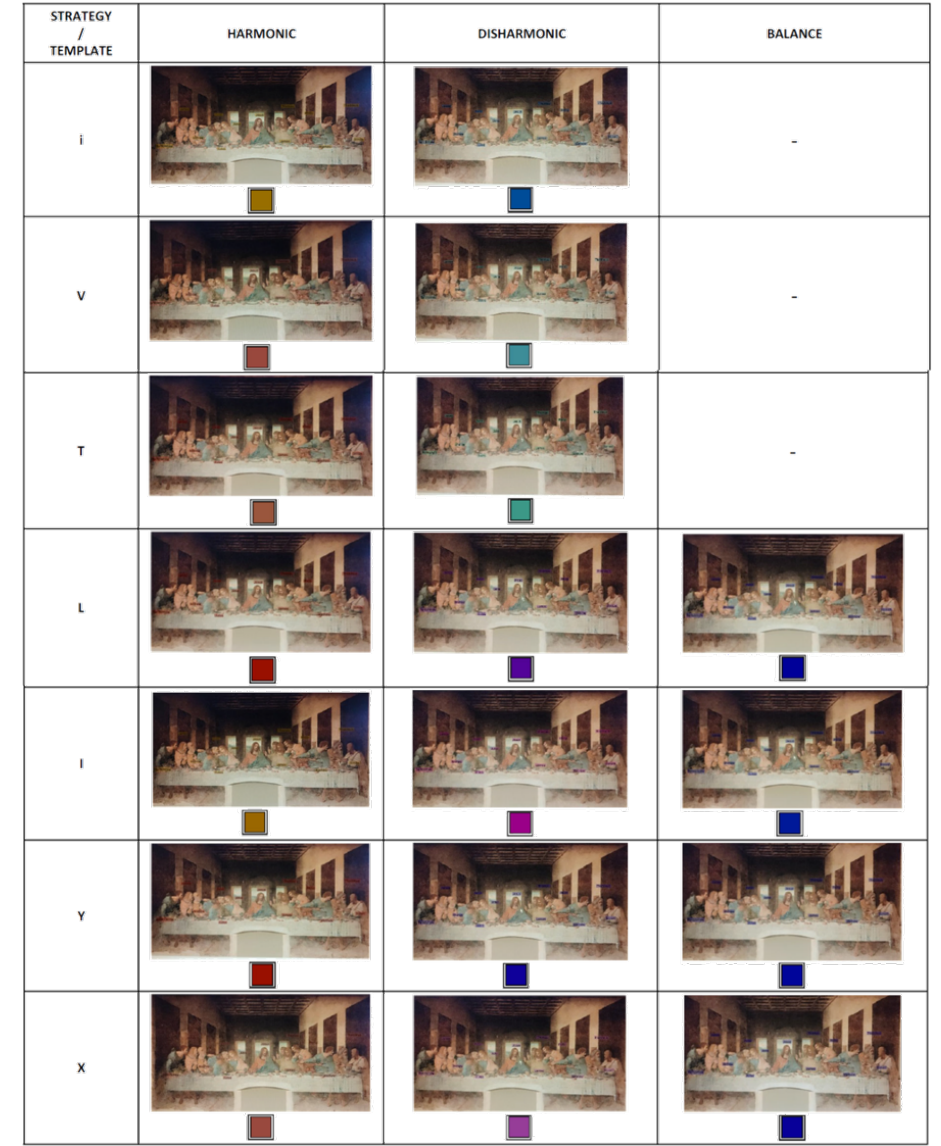
Figure 11. Recolored labels by applying all templates and the three